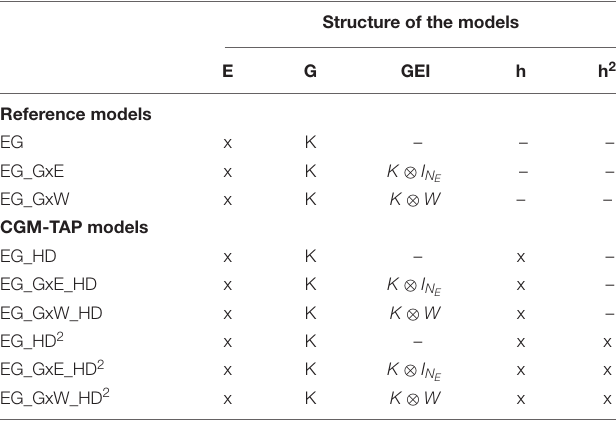
TABLE 2 | Description of the reference and CGM-TAP models. Structure of the